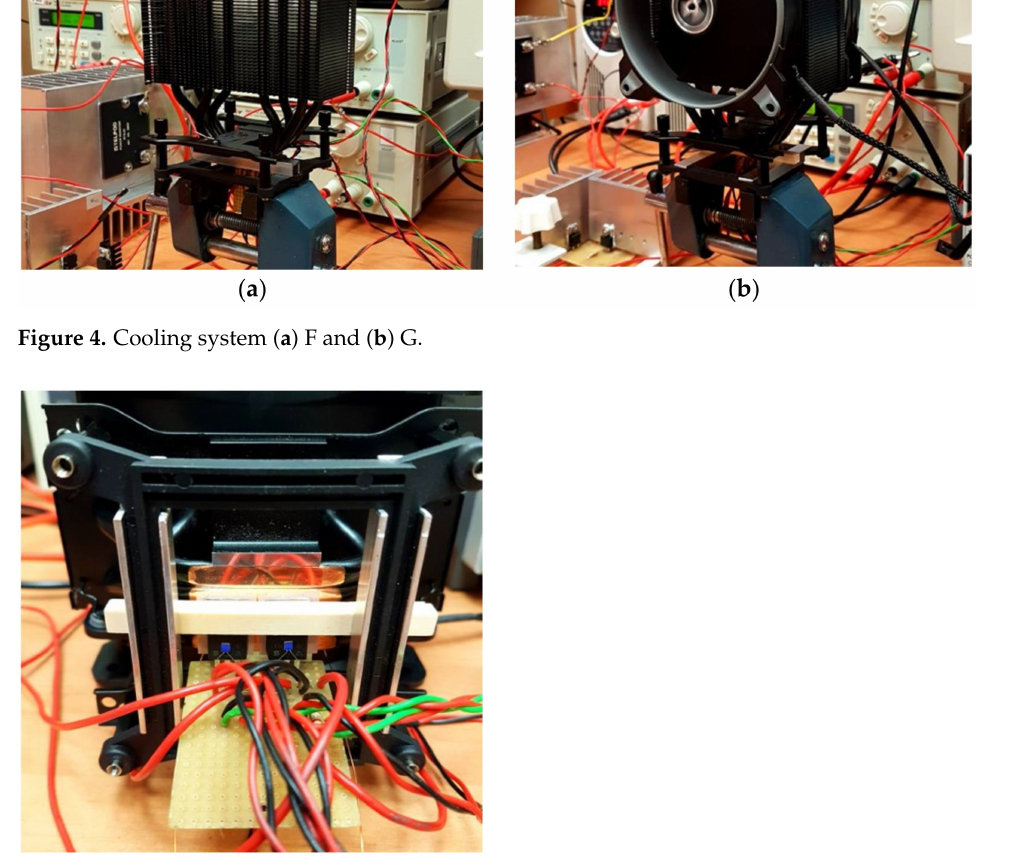
Figure 5. Manner of attaching the investigated MOSFETs to the base of the cooling systems F and